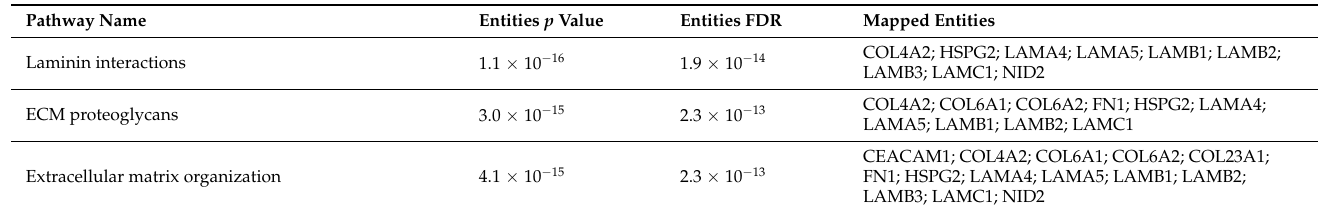
Table 1. Significantly altered pathways (by upregulated proteins with directed